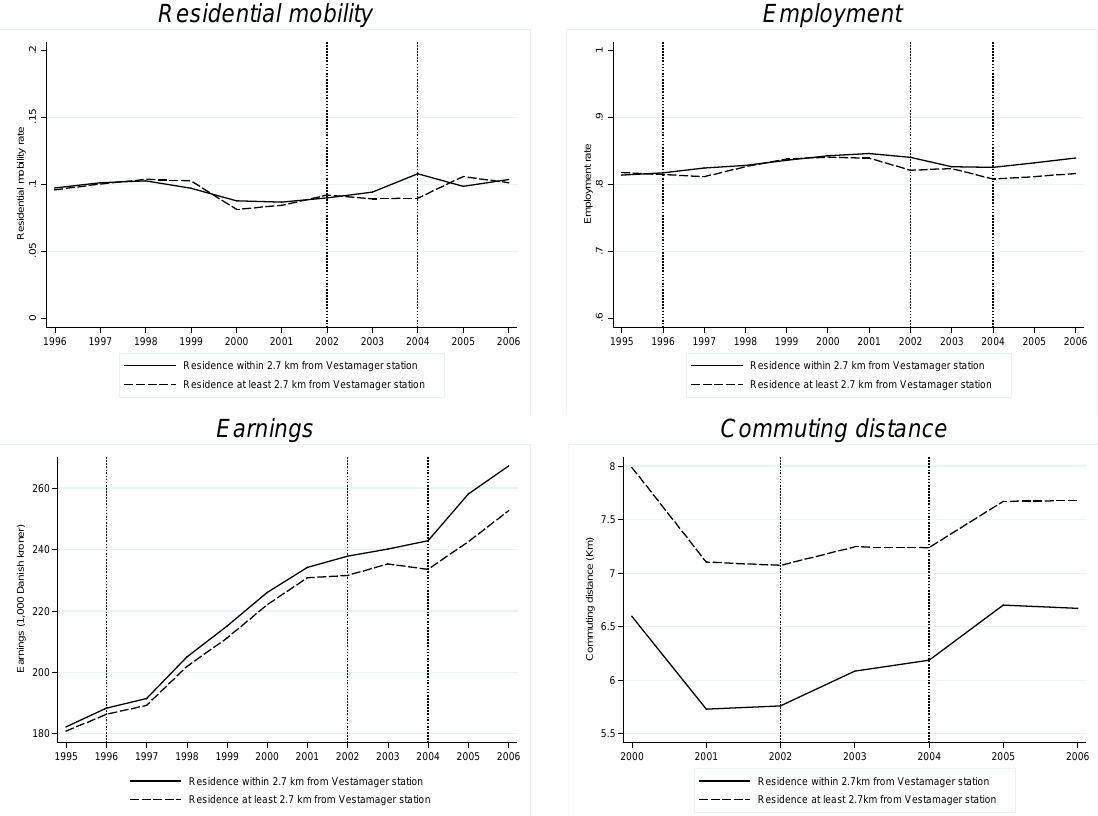
Figure 3. Residential mobility, labour market outcomes and commuting in 1995-2006 Notes: The vertical dashed lines in years 1996, 2002 and 2004 indicate the announcement of the construction of the Metro, the inauguration of Vestamager station with Phase 1, and the expansion of the Metro with Phase 2